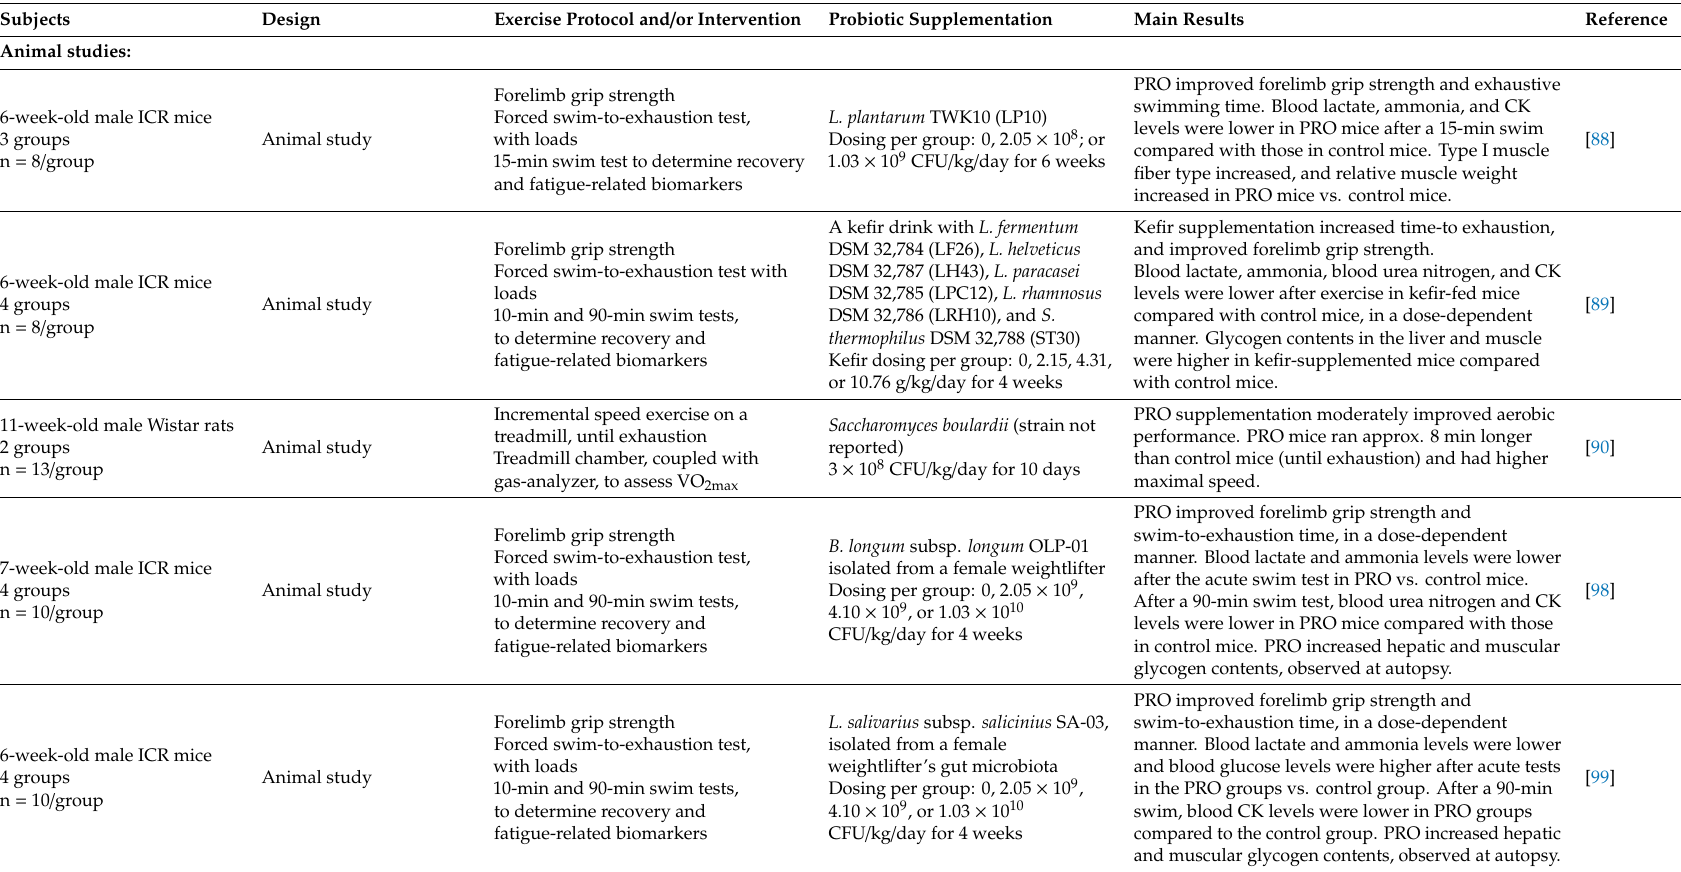
Table 2. Probiotic studies on physical performance, post-exercise recovery and cognitive